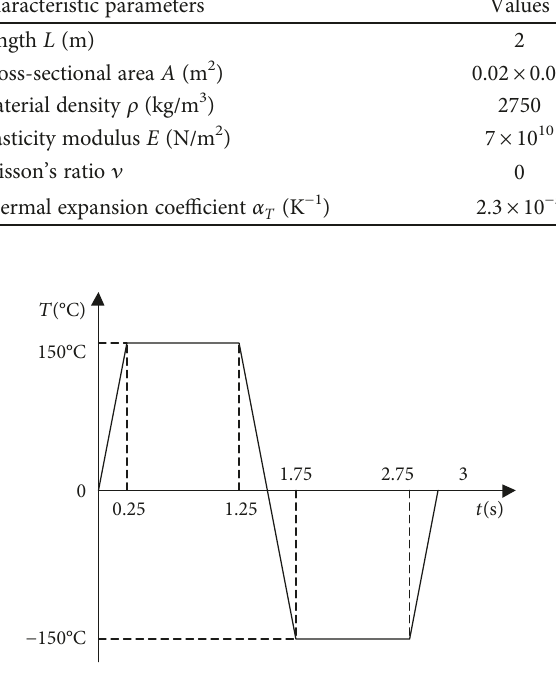
Figure 6: Temperature pro fi le with